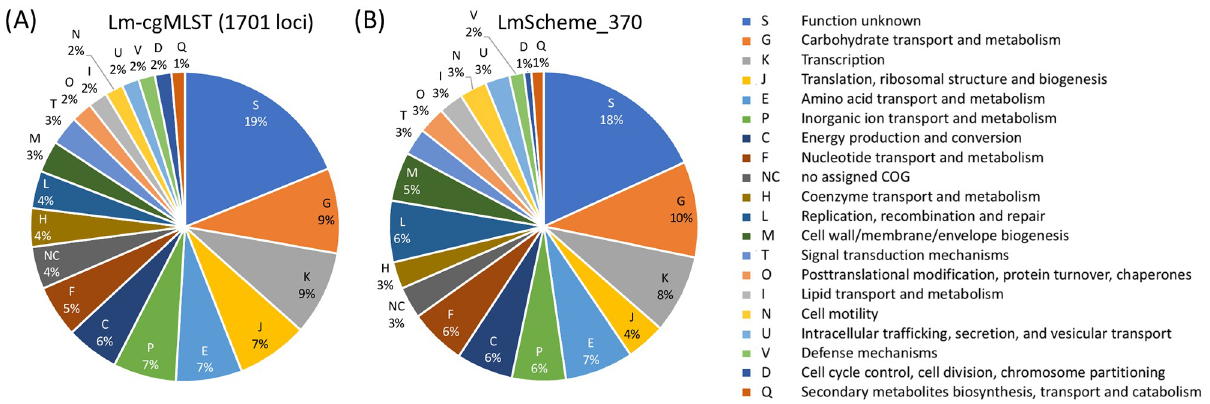
Fig 2. Distribution of COG functional classes for the loci of (A) Lm-cgMLST (1701 loci) and (B) LmScheme_370.